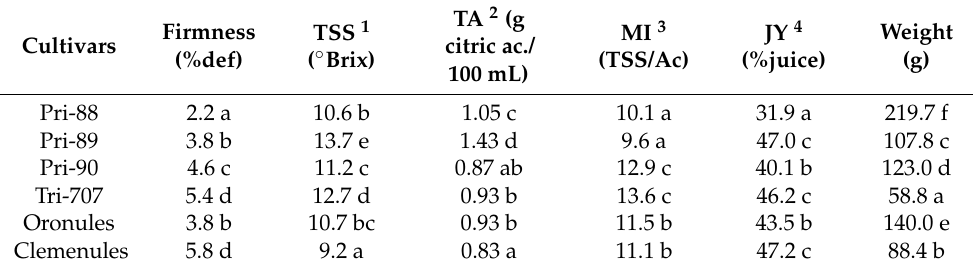
Table 2. Physico-chemical parameters of the six mandarin cultivars. Firmness Cultivars